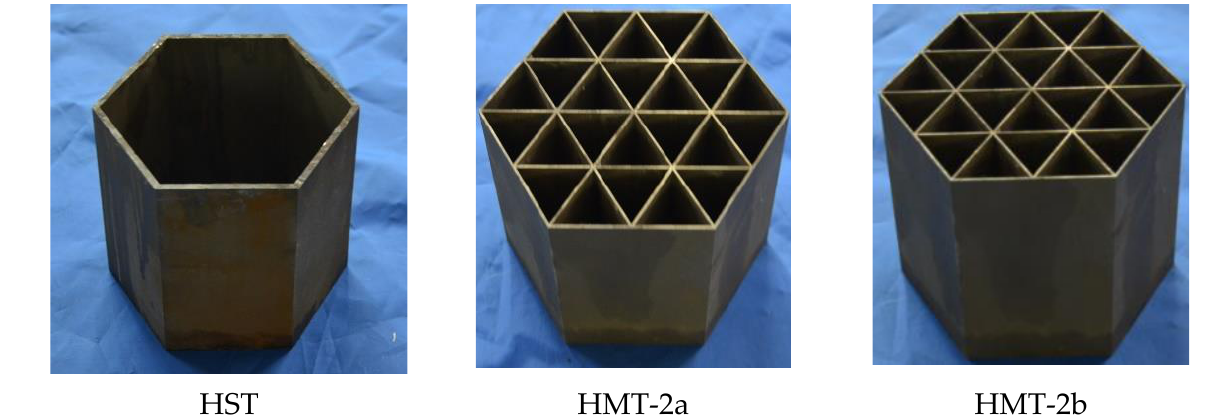
Figure 2. Manufactured thin-walled steel hexagonal tubes.